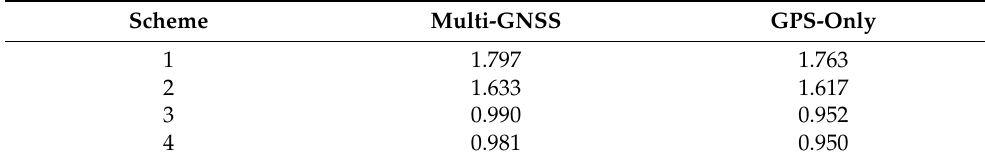
Table 3. Comparison of the mean values of 20 sets of RMSEs (g/m 3 ) for the whole profile resulting from multi-GNSS and GPS-only data, and four schemes over the period